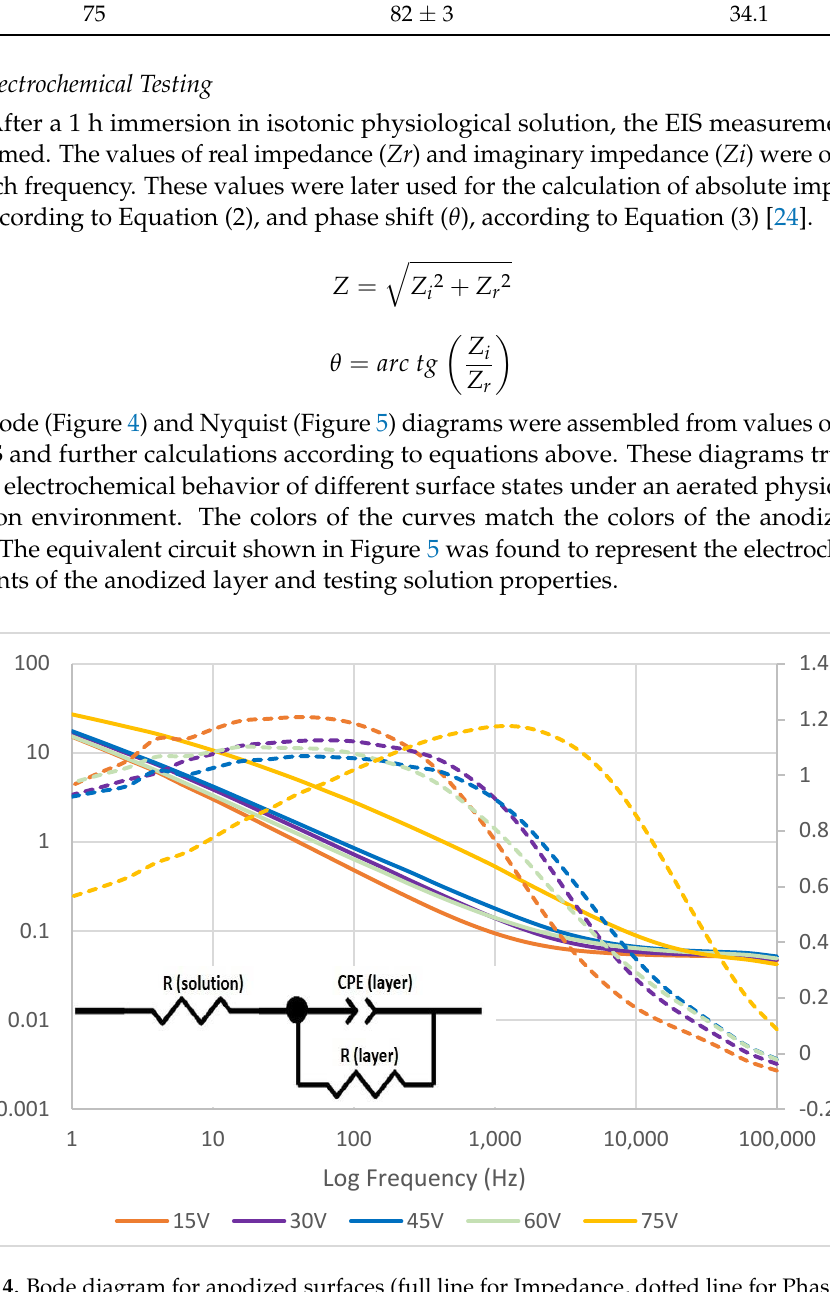
Figure 4. Bode diagram for anodized surfaces (full line for Impedance, dotted line for Phase shift) .